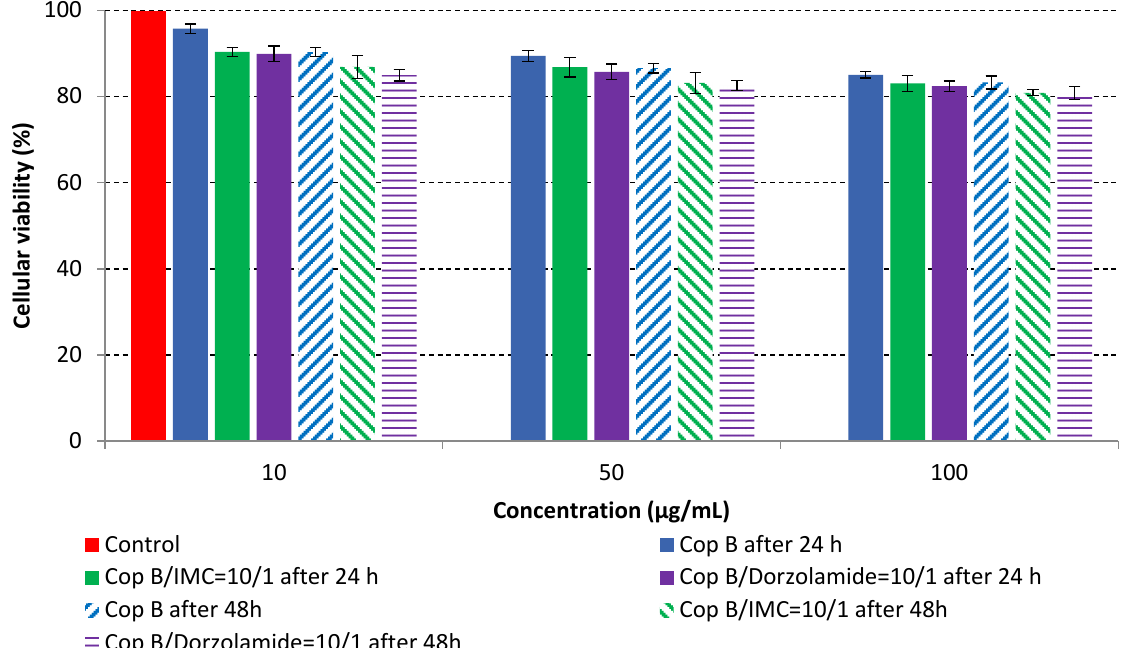
Figure 5. In vitro cell viability of PMs as a function of concentration and time.